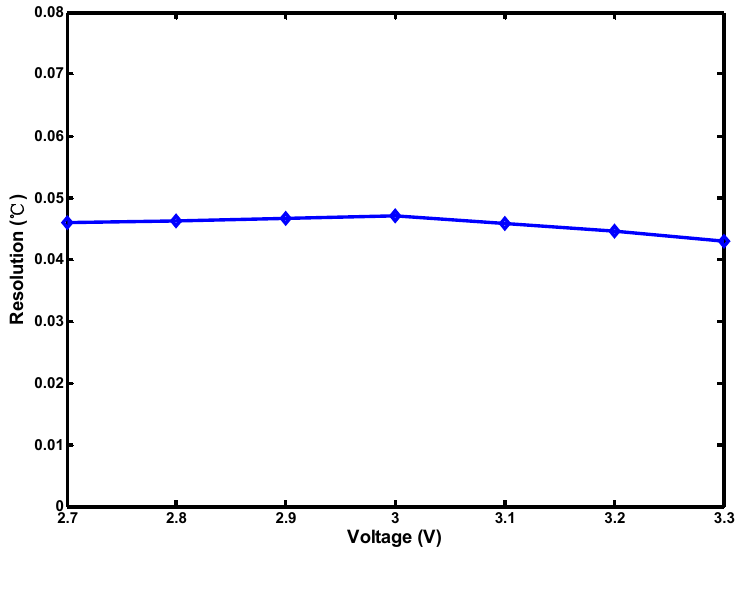
Figure 16. Effective resolution variation under ± 10% supply voltage variation.